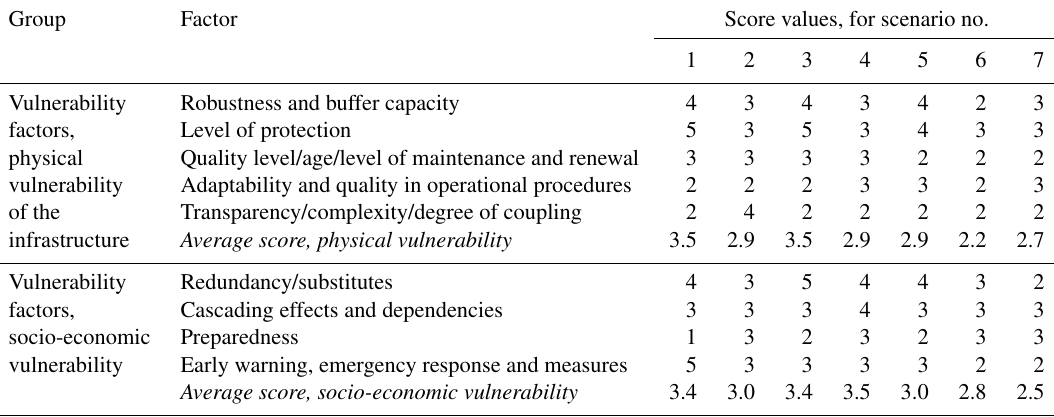
Table 8. Ranking of indicators and determination of physical and socio-economic vulnerability scores. The first column shows the indicator group (i.e. physical or socio-economic vulnerability), the second column the vulnerability indicator and the next columns the score values for the scenarios.